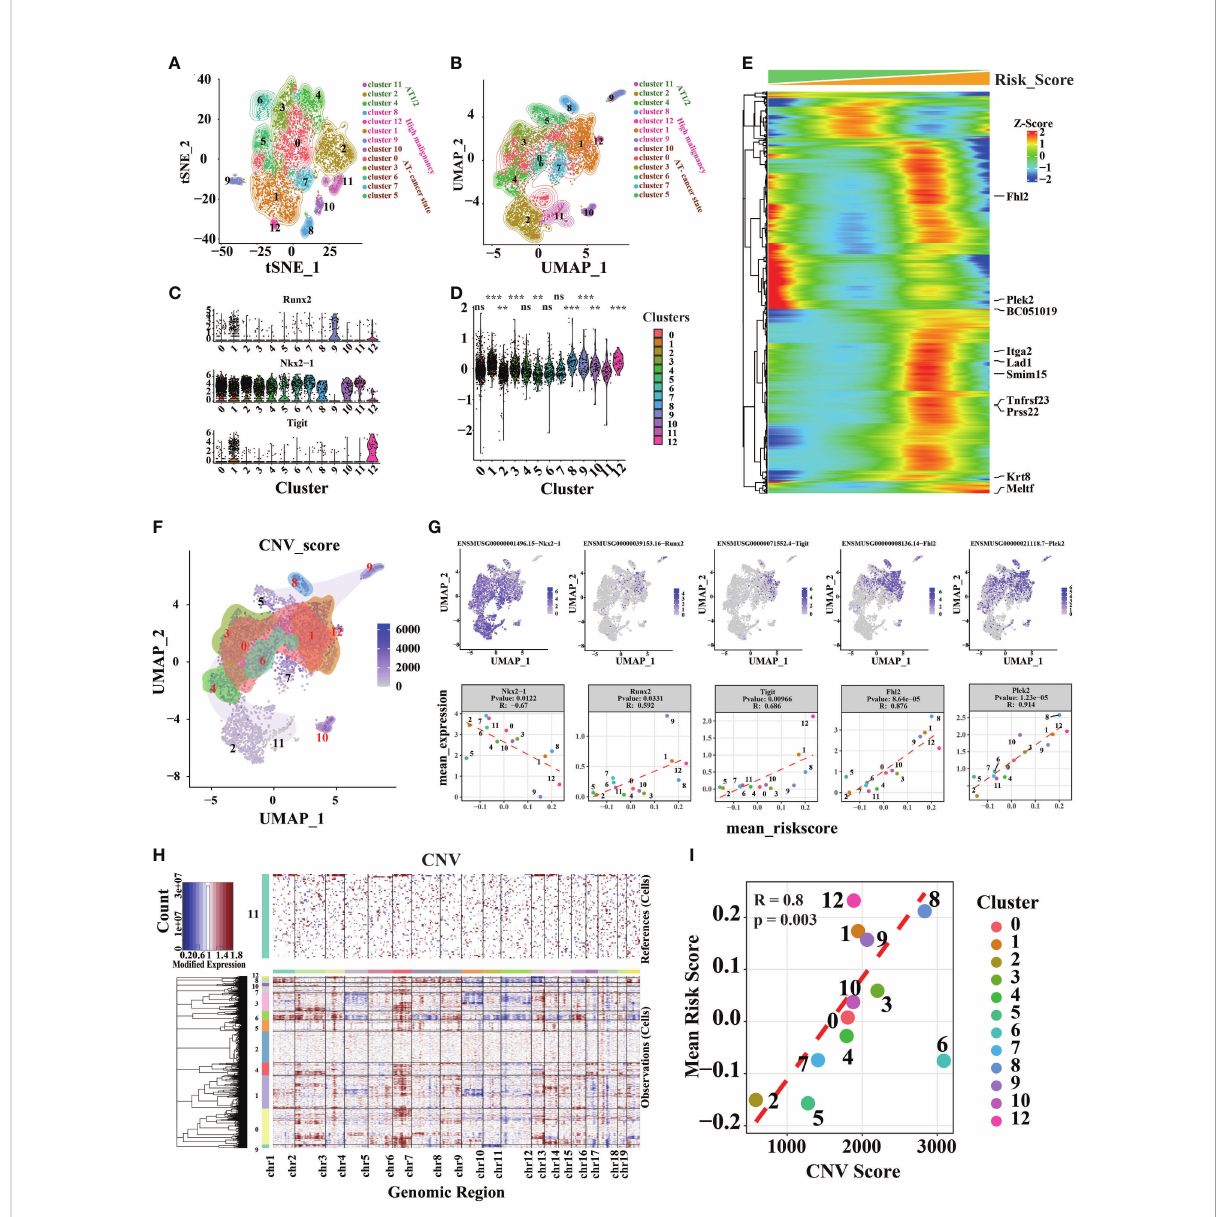
FIGURE 6 Different cell clusters identi fi cation and annotation in LUAD scRNA-seq data. (A) Seurat V4 was used to cluster and classify single cells, and t- SNE dimensional-reduction scatter diagram of sequencing data. (B) Sequencing data UMAP dimensional-reduction point scatter diagram. (C) Expression levels of genes associated with lung cancer development in different clusters. (D) The distribution of risk scores calculated by the prognostic signature in different cell clusters ( “ ns ” is non-signi fi cant compared with cluster 11, *P< 0.05, **P< 0.01, ***P< 0.001, ****P< 0.0001). (E) genes associated with risk score (P.value< 10 -25 , the genes marked on the right are the 10 genes with the strongest correlation). (F) Distribution of CNV in UMAP dimensionality reduction map. (G) Genes associated with risk scores in scRNA-seq data. (H) InferCNV was used to predict the CNV of cells, and heat maps of the distribution of CNV of different chromatin of different cells. (I) Average CNV score and risk score points from different clusters are scattered fi